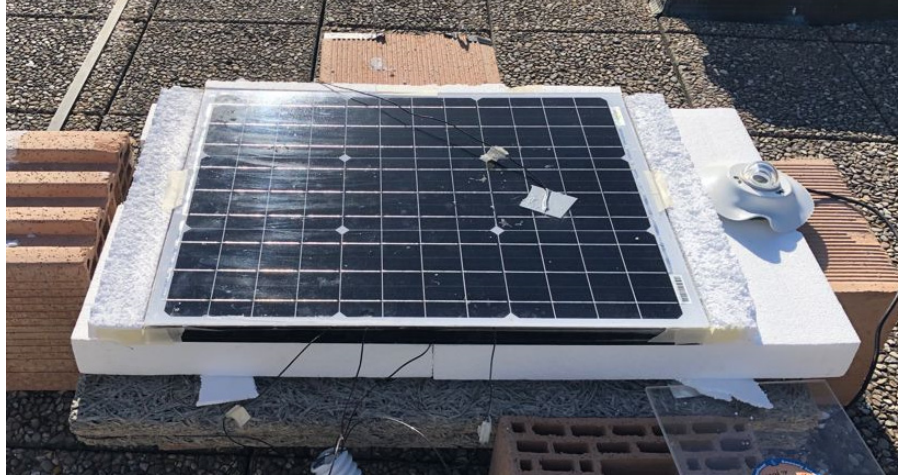
Figure 10. Experimental outdoor setup.